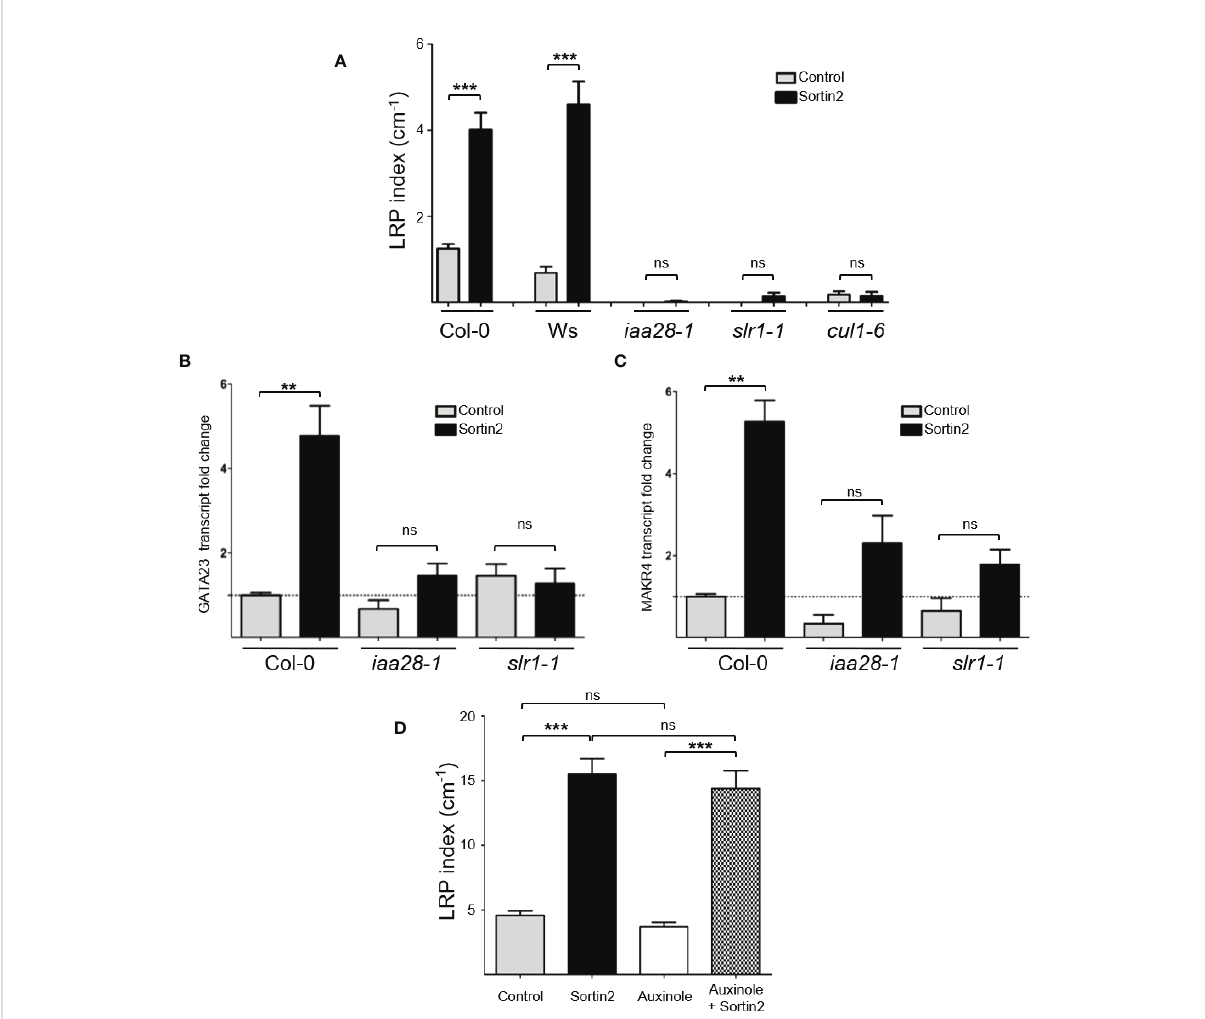
FIGURE 4 Endomembrane traf fi cking induction of lateral root founder cell speci fi cation occurs upstream of AUX/IAA28 and AUX/IAA14 degradation and depends on CUL1, a SCF complex component. (A) Seven-day-old seedlings of the wild types (Col-0 and Ws) and the mutants iaa28-1 , slr1-1 , and cul1-6